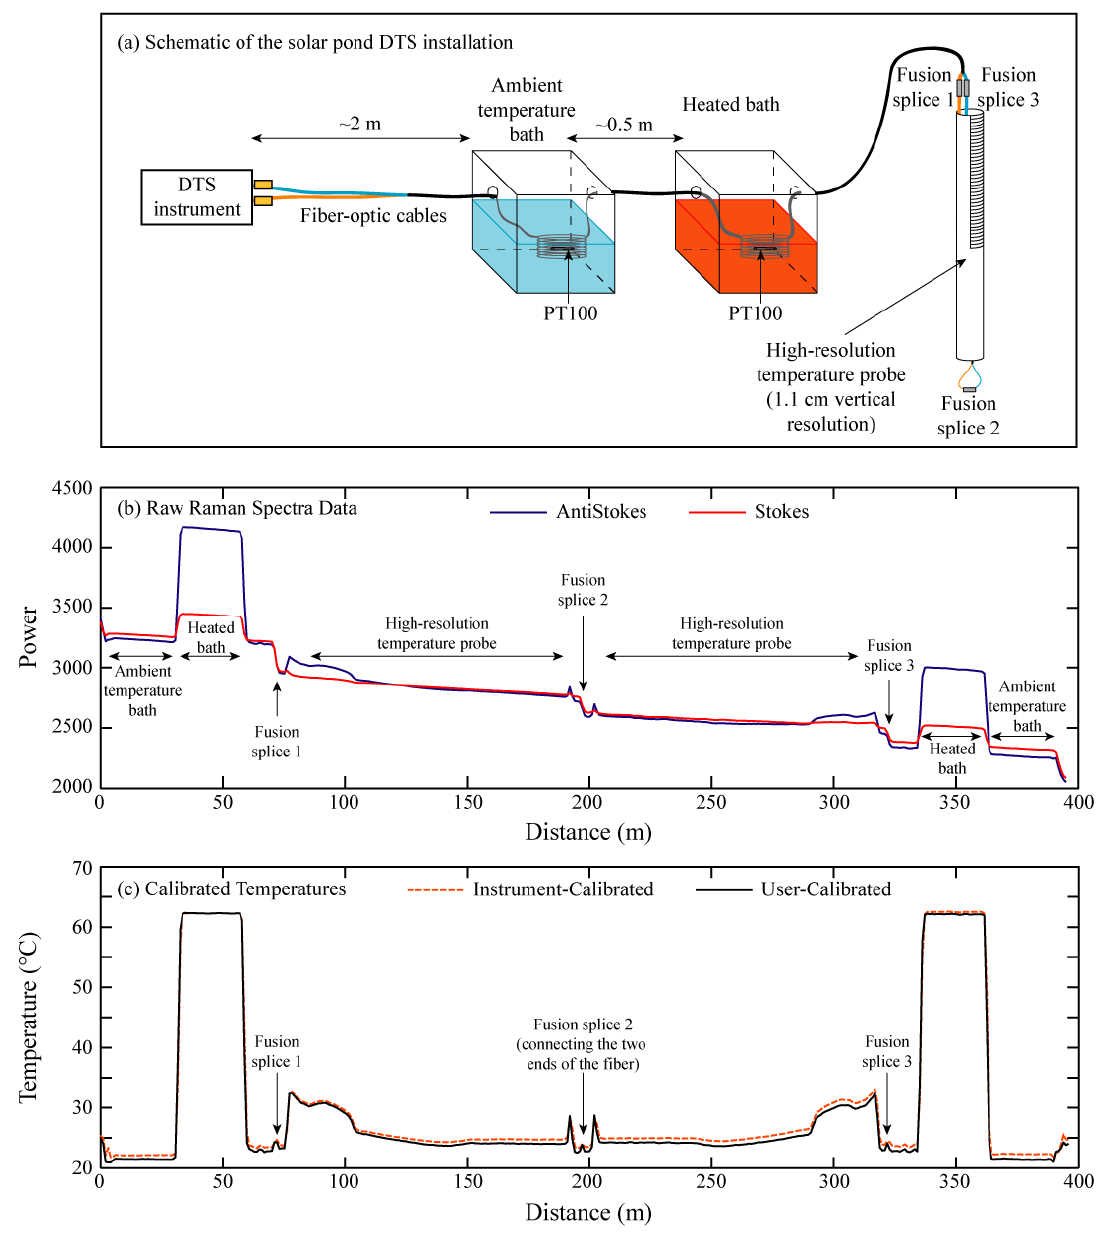
Figure 2. The laboratory solar pond installation. (a) Schematic of the laboratory configuration; (b) Raw Raman spectra data (recorded by the DTS instrument in arbitrary units linearly related to the power of the scattered signals) and the locations of calibration baths for a sample 5 minute DTS trace; (c) Temperatures (both instrument-calibrated and user-calibrated) and the locations of fusion splices for a sample 5 minute DTS